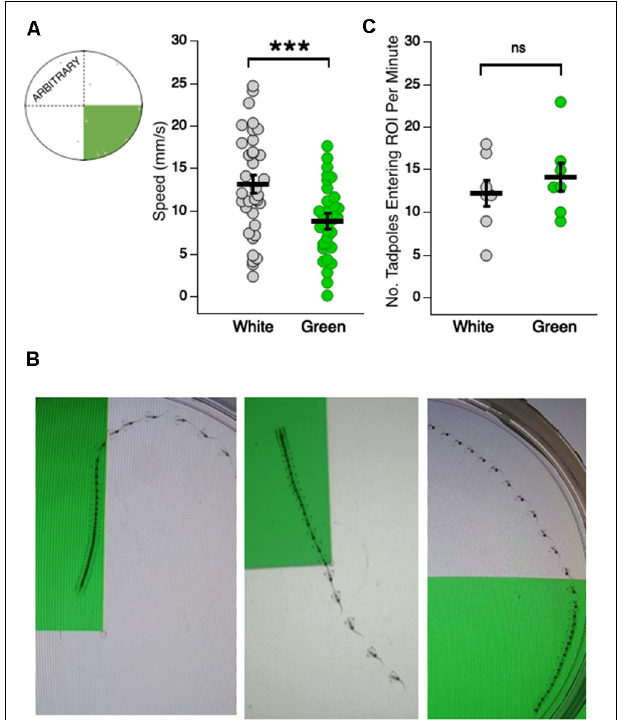
FIGURE 2 | Tadpoles swim slower in the green region of the test dish. ( A , far left) Schematic showing the arbitrary white quadrant used for quantifying swimming speeds in the white region; (right) dot plot of swimming speeds while in the white and green region of the test dish (*** p < 0.001). Each dot represents the recorded speed of an individual tadpole. (B) Merged video frames showing (left and middle panels) single tadpoles slowing down upon entering the green region of the dish, and (right) a tadpole speeding upon swimming out of the green and into the white region. The faster the tadpole is swimming, the greater distance traveled between frames and visa versa. (C) Dot plot showing the number of times a given tadpole entered a designated white quadrant of the dish, and the number of times they entered the green quadrant (ns = not significant). The probability of freely-swimming tadpoles to enter the green quadrant of the dish is not statistically different from the probability of their moving into a designated white quadrant.